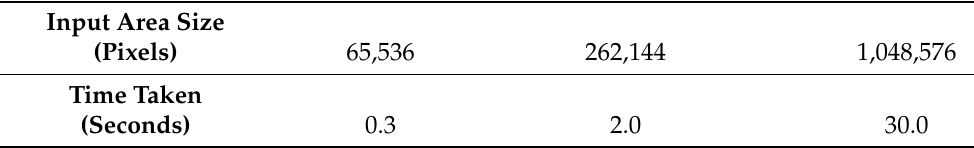
Table 1. Running durations for the reaction-diffusion algorithm implemented on CUDA. The durations are for only one v m